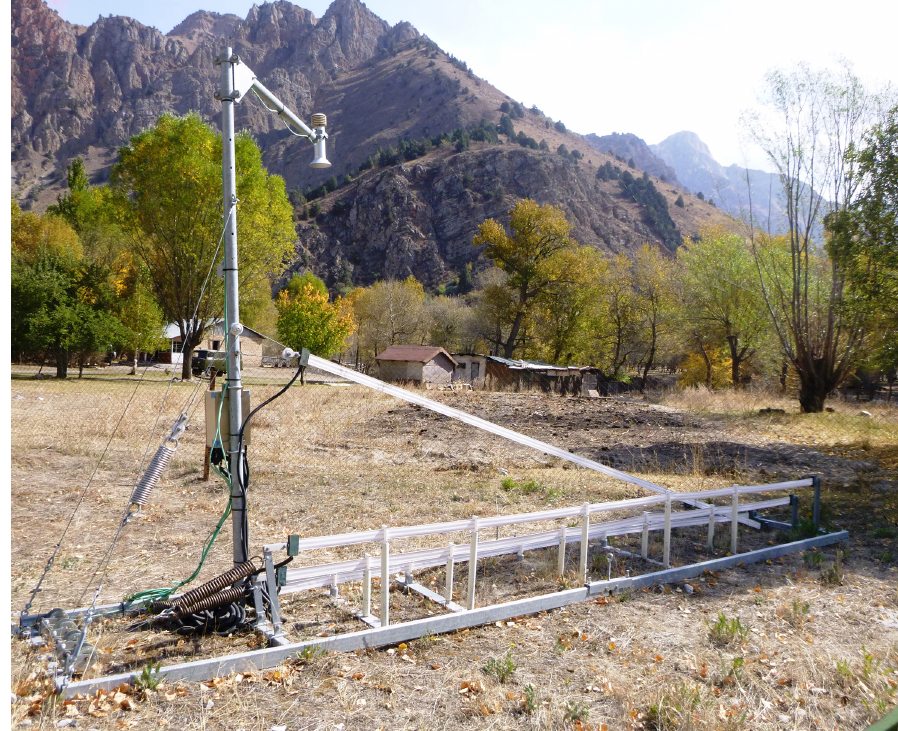
Figure 7. Snow pack analyser (SPA) with the ultrasonic snow depth sensor (USH-8) and the four flat ribbon sensors (three horizontal and one sloping sensor) at the station Maydantal